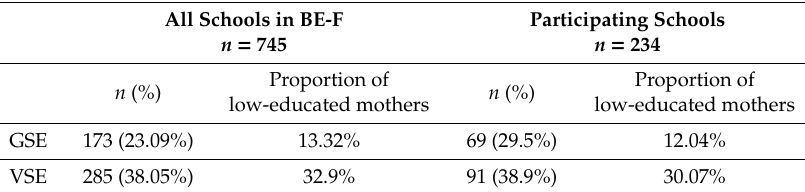
Table 1. Sample Distribution According to School Type and Socioeconomic Status (SES) with Respect to the Total Population.